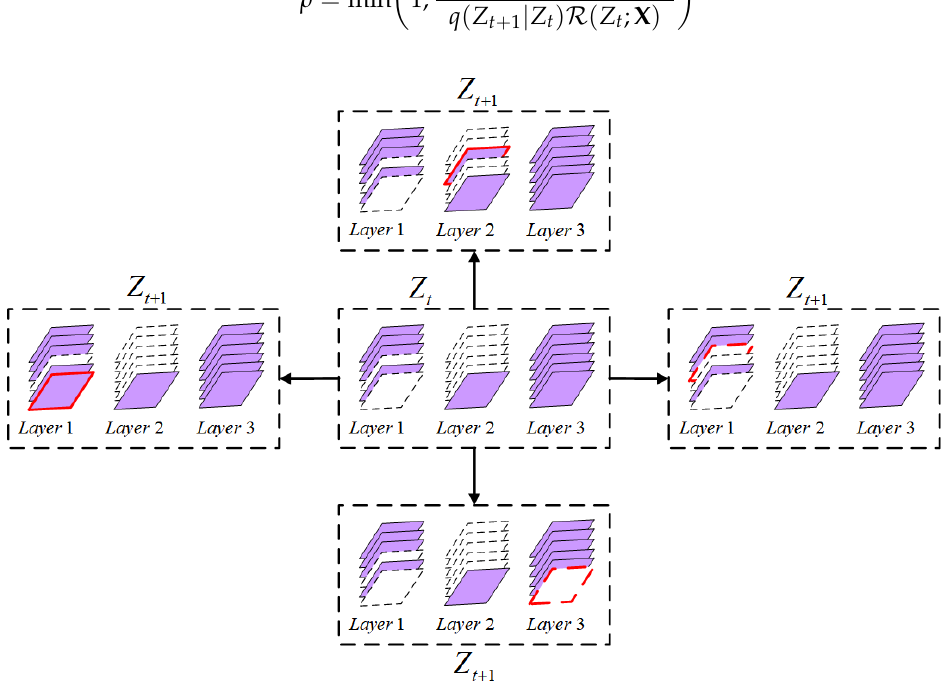
Figure 2. Illustration of feasible transitions from current state Z t to next state Z t + 1 under ε = 2. The added or deleted channel is marked by red